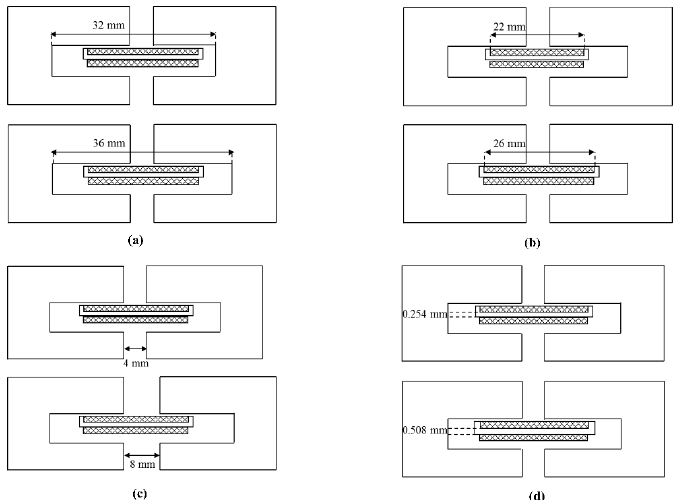
Figure 10. The effect plots for normalized leakage rate (screening experiments).